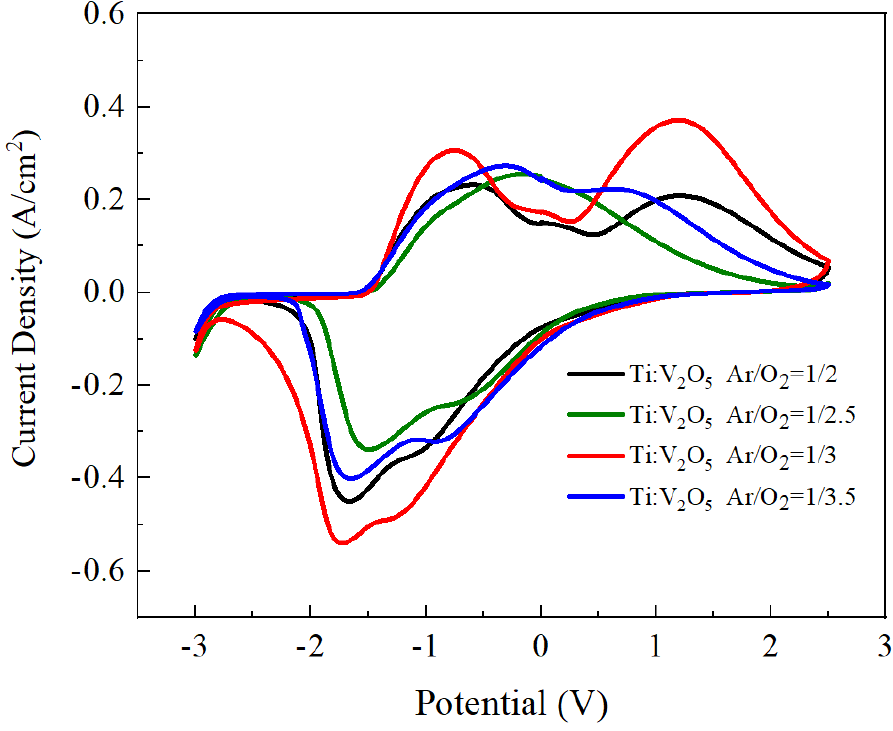
Figure 3. CV curve of Ti:V 2 O 5 electrode films with various Ar/O 2 gas flow ratios at the 25th cycle with a scan rate of 100 mV/s.